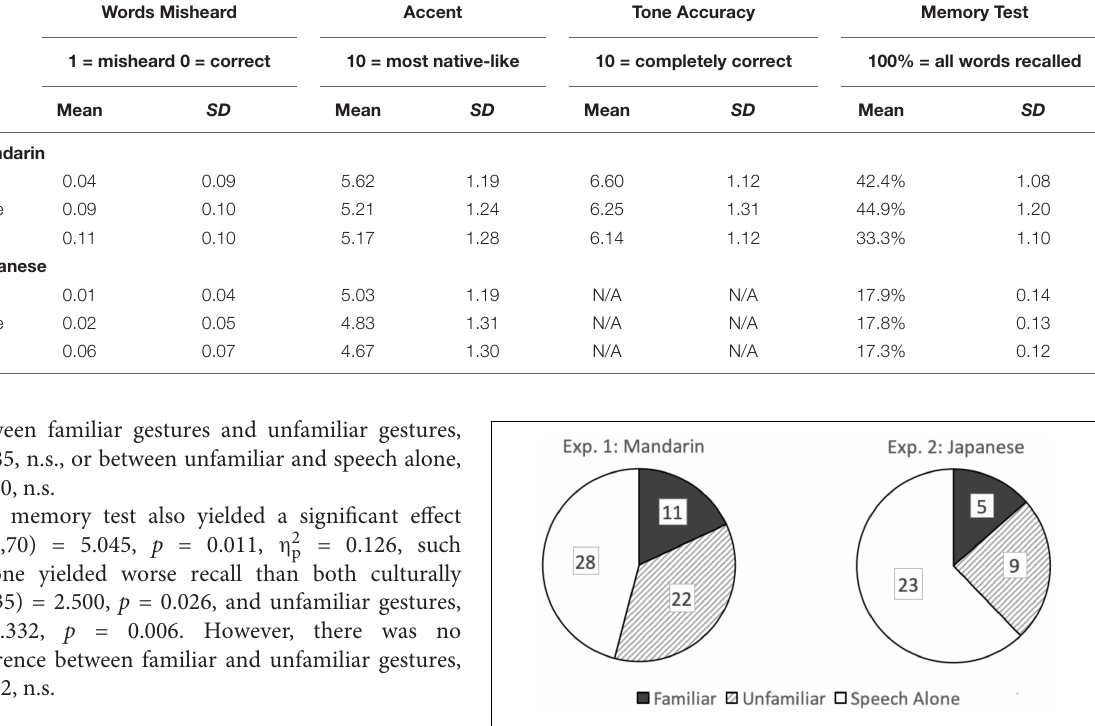
FIGURE 2 | Number of words misheard in each of the familiar-gesture, unfamiliar-gesture, and speech-alone conditions.